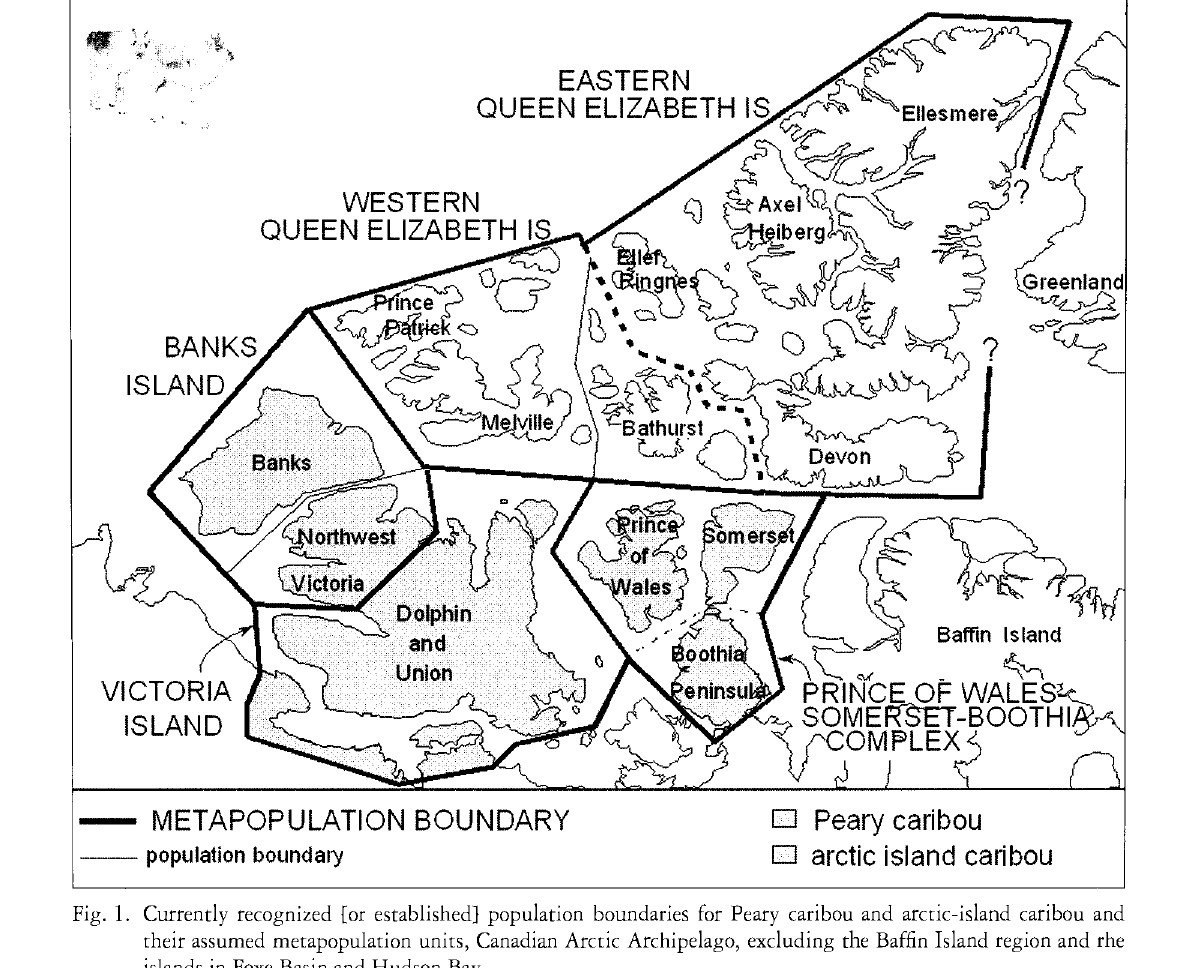
Fig. 1. Currently recognized [or established] population boundaries for Peary caribou and arctic-island caribou and their assumed metapopulation units, Canadian Arctic Archipelago, excluding the Baffin Island region and rhe islands in Foxe Basin and Hudson